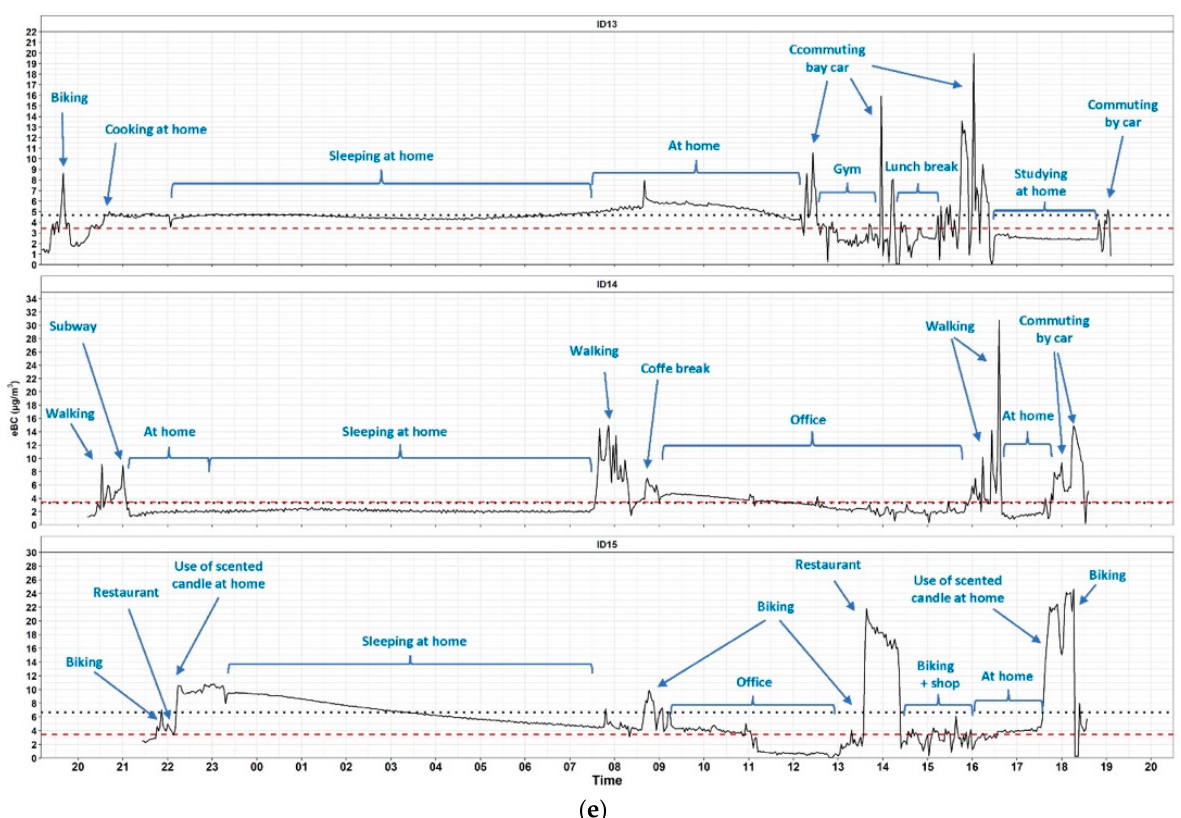
Figure 4. Twenty-four hour time series of personal equivalent black carbon (eBC) exposure concen- trations. the sub-figure ( a ) shows the trends of the BC concentrations of ID1, ID2, ID3. The sub-figure ( b ) shows the trends of the BC concentrations of ID4, ID5, ID6. The sub-figure ( c ) shows the trends of the BC concentrations of ID6, ID7, ID8. The sub-figure ( d ) shows the trends of the BC concentrations of the ID9, ID10, ID11 and the sub-figure ( e ) the trends recorded by the ID12, ID13, ID14. (Red benchmark: average concentration measured in the fixed station of Lingotto. Black benchmark: av- erage concentration of eBC measured by the AE51 aethalometers).